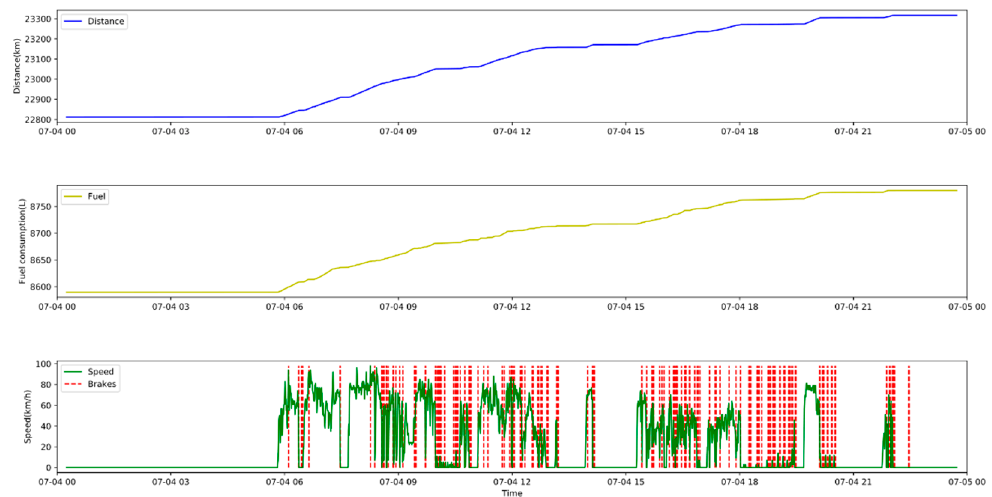
Figure 2. Distance covered, fuel consumption, speed and braking of a vehicle in the course of one day.